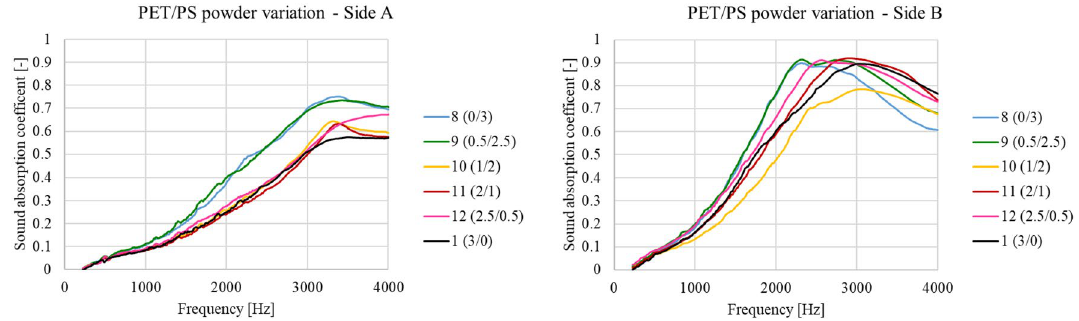
Figure 10. Variation of sound absorption frequency coefficient with varying microplastics powder ratios.